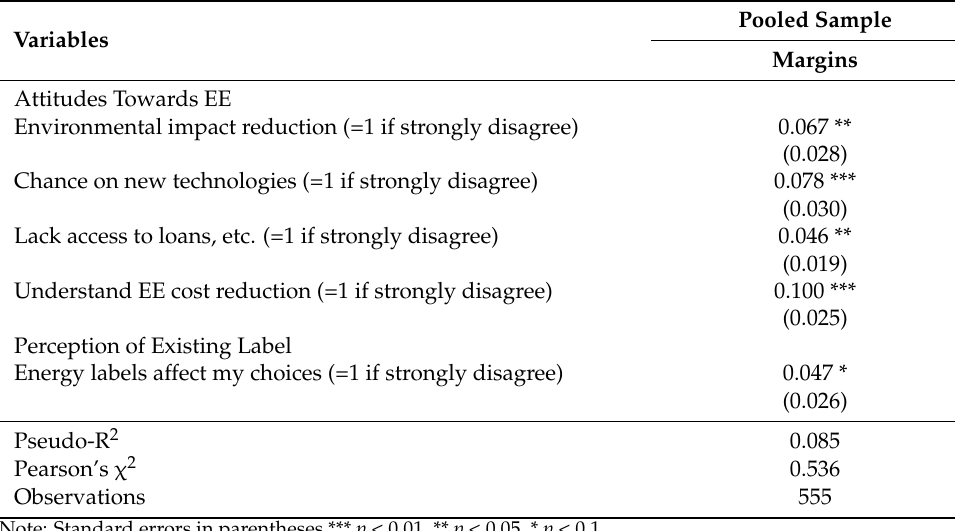
Table 9. Variables affecting firms’ perceptions of energy efficiency—probit marginal effects (pooled